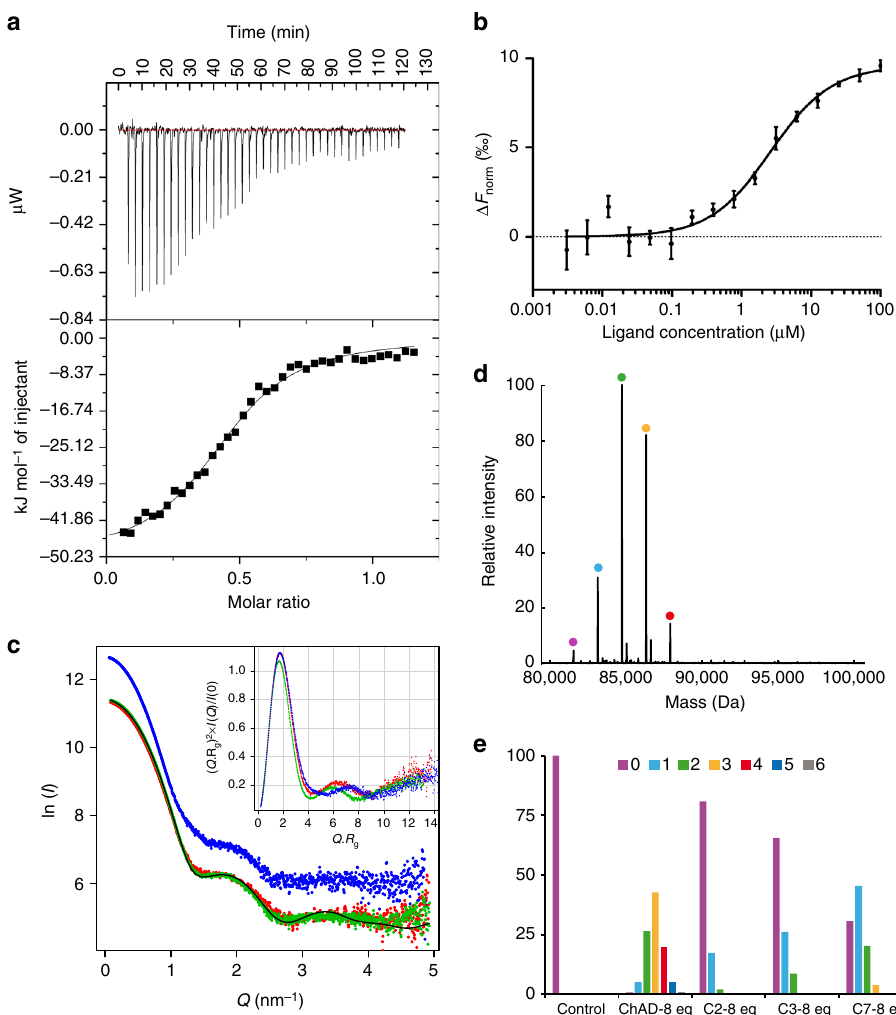
Fig. 4 Molecular analysis of ChAD binding to Mtb -SecB TA . a ITC pro fi le of ChAD titration into Mtb -SecB TA (upper and lower parts represent raw and integrated binding heats, respectively). b Differences in normalized fl uorescence generated by various concentrations of ChAD added to Mtb -SecB TA during MST analysis and calculated fi t. Error bars are as calculated with the NanoTemper analysis software based on independent experimental data. c Experimental SAXS data for Mtb -SecB TA in the unbound state (red line), in the presence of ChAD (green line), and for the complex formed with Mtb - HigA1 (blue line) and comparison with the theoretical scattering patterns computed from the Mtb -SecB TA /ChAD structure (black line). The inset shows the SAXS - derived Kratky plots. d Deconvoluted native mass spectrum of Mtb -SecB TA incubated with 4 molar equivalents of ChAD peptide. The species detected correspond to the Mtb -SecB TA tetramer (MW 81,575 Da, purple circle) and to the binding of up to four ChAD peptides with MWs of 83,157; 84,746; 86,334 and 87,922 (cyan, green, orange, and red, respectively). e Native MS-derived relative abundance of the different species obtained upon titration with 8 molar equivalents of the ChAD peptide and other 13-mer peptides evaluated in this study (peptide numbering is according to ref. 29